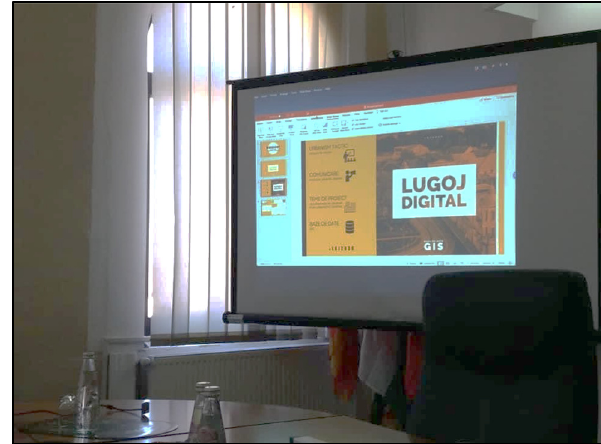
Figure 2. A detail of the City Hall of Lugoj workshop, focused on urban regeneration processes using digital tools and GIS analysis (photo taken by the author, 2021) .